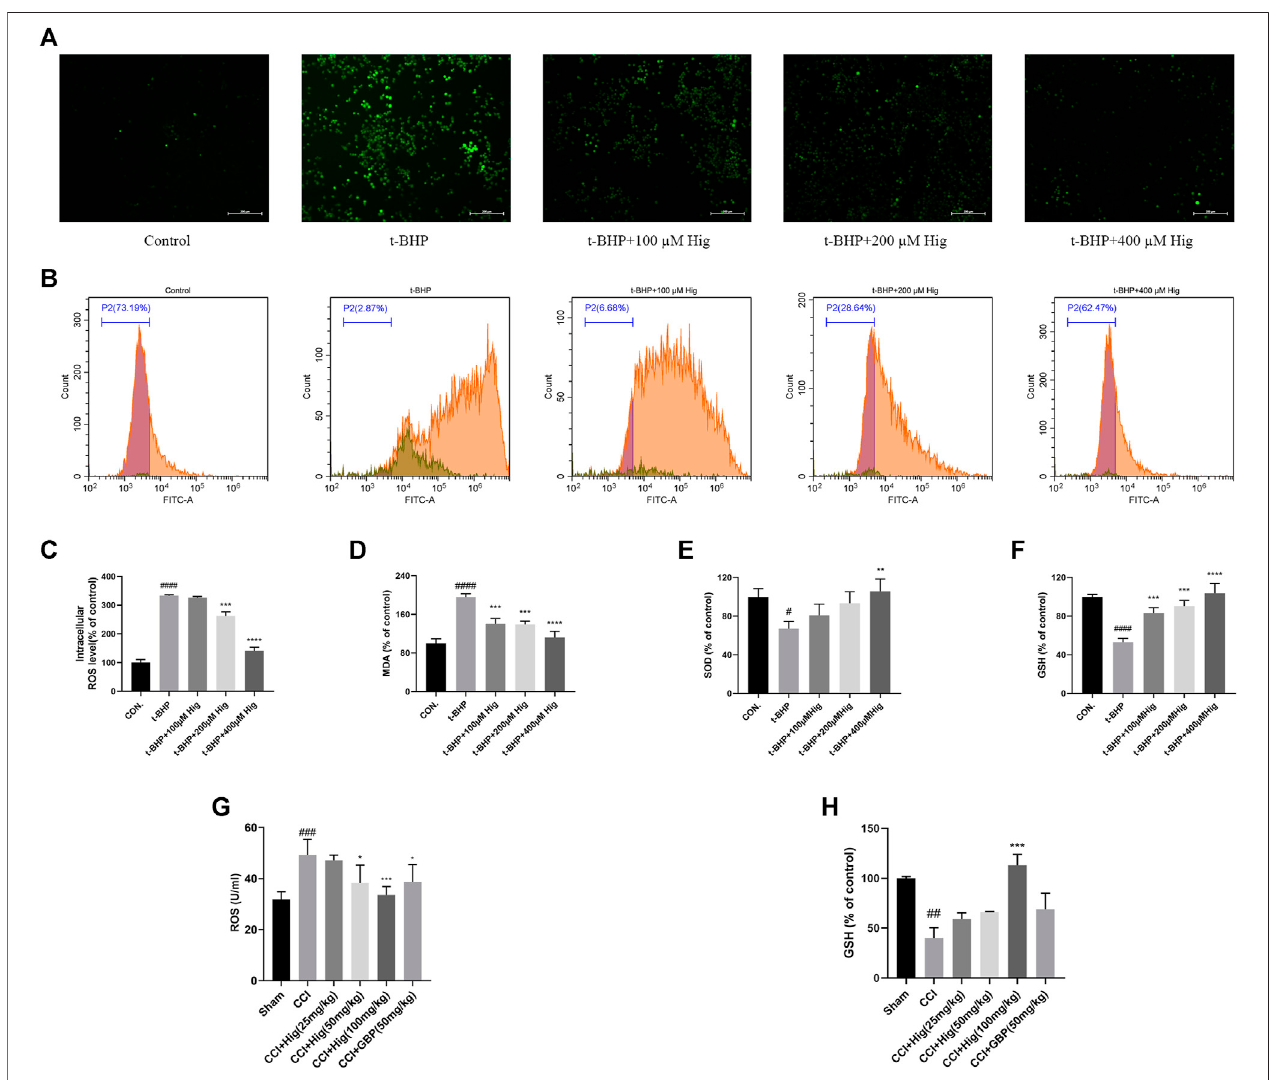
FIGURE 2 | Hig prevented RSC96 and DRG neuron from oxidative stress damage. (A) RSC96 intercellular level of ROS stained by DCFH-DA dye was observed under the microscope. Scar bar (cid:2) 200 µm. (B) RSC96 intercellular level of ROS stained by DCFH-DA dye was observed by fl ow cytometer. (C) The ratios of RSC96 intercellular ROS level compared with the control group were calculated. (D) Quanti fi cation of RSC96 intercellular MDA level in different groups. (E) Quanti fi cation of RSC96 intercellular SOD level in different groups. (F) Quanti fi cation of RSC96 intercellular GSH level in different groups. (G) The ROS level in rats ’ DRG tissue was detectedbyELISA kit. (H) Comparison ofGSH level inrat DRGtissuesamongdifferentgroups. The resultsare presented asmean ± SEM, n (cid:2) 3. # p < 0.05, ## p < 0.01, ### p < 0.001, and #### p < 0.0001 vs. the control group. * p < 0.05, ** p < 0.01, *** p < 0.001, and **** p < 0.0001 vs. the model group.